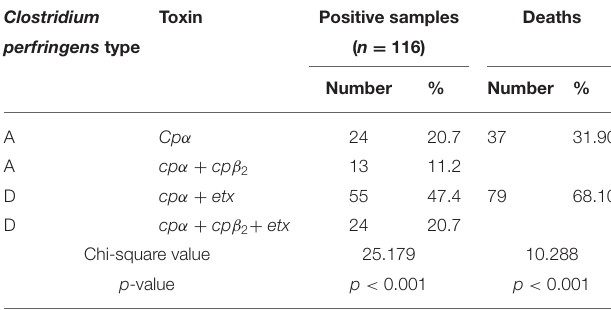
TABLE 6 | Toxinotypes involved in outbreaks of enterotoxemia in